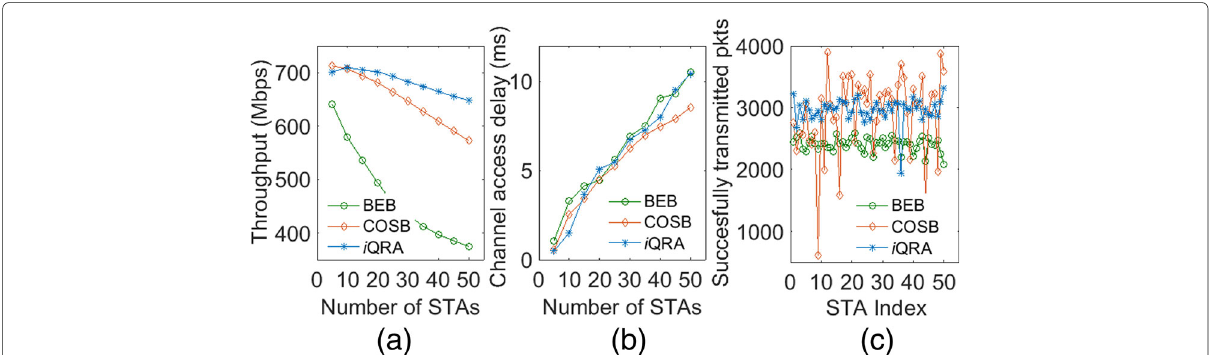
Fig. 7 Comparison of BEB, COSB, and i QRA for a throughput (Mbps), b channel access delay (ms), and c successfully transmitted packets (fairness)